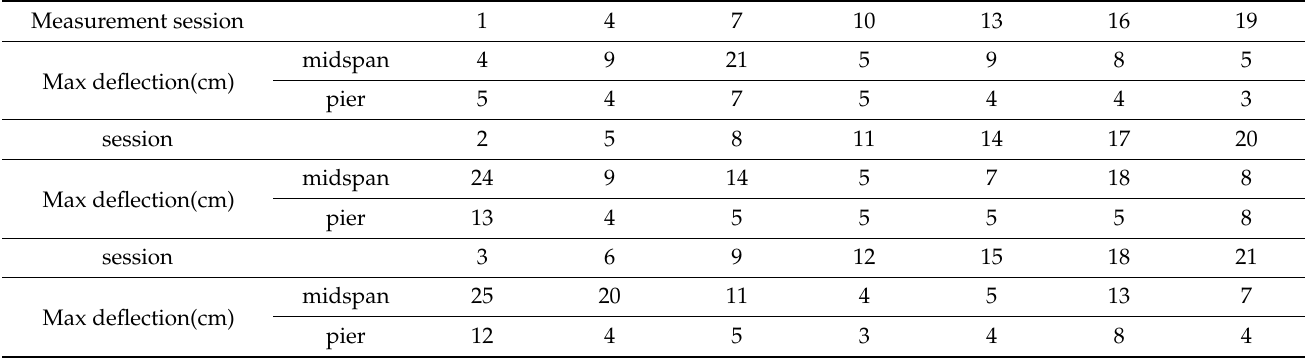
Table 3. Maximum vertical dynamic displacements of the Juarez bridge. Data based on Figure 9 in [30]. Measurements were collected from 6 GPS instruments during 21 sessions, which are divided in this Table in three sets of seven sessions each, with inferred quasi-similar satellite constellations. Four instruments were set above bridge piers (and are typically expected to show no deflections) and two at the midspan. Large apparent deflections were reported, up to 13 cm above piers and up to 25 cm in the midspan. This order of apparent deflections is much higher than those observed on other bridges and is expected only at bridge destruction level (cf. Table